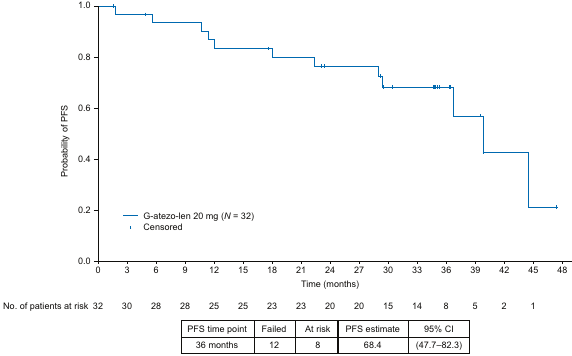
Fig. 2 Kaplan – Meier estimate of INV-assessed progression-free survival amongst patients with relapsed/refractory follicular lymphoma (ef fi cacy-evaluable population; 36-month cutoff: 7 October 2020). The median observation time was 35.9 months [range 3 – 47 months].